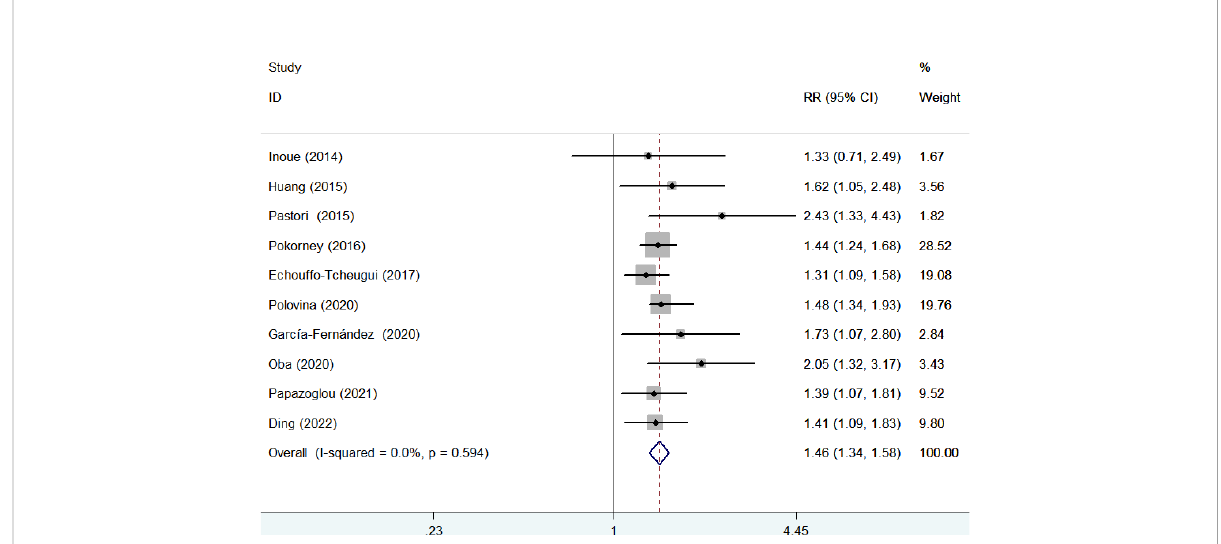
FIGURE 4 Forest plot showing the pooled risk ratio (RR) with 95% CI of major bleeding for those with diabetes versus those without